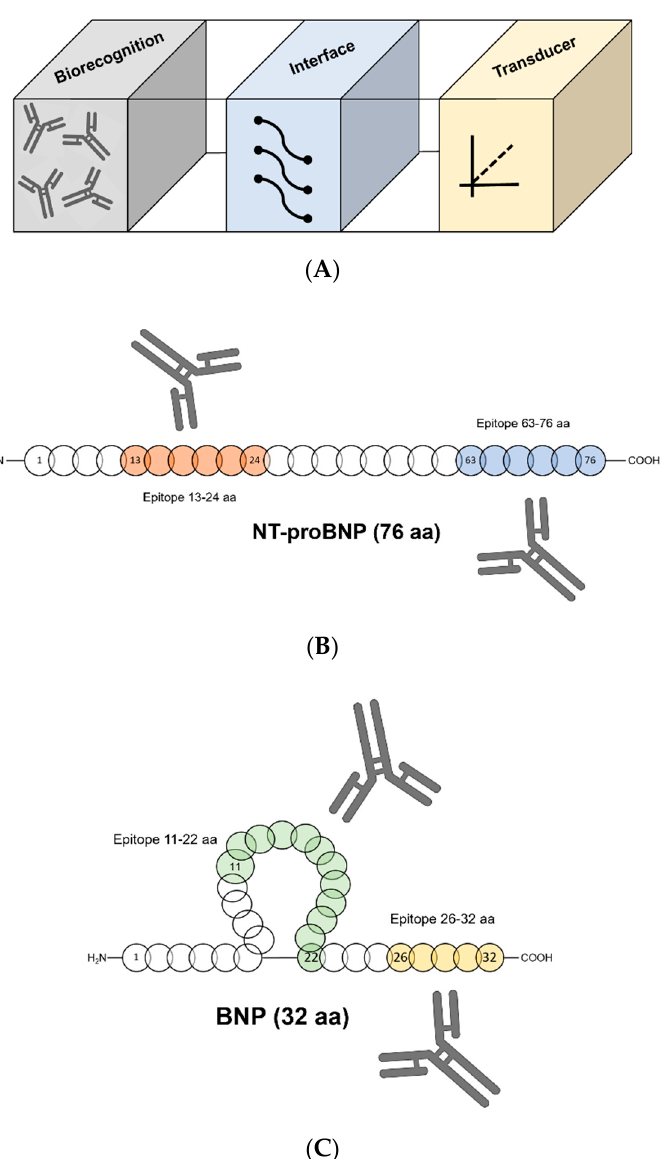
Figure 3. Detection of B-type natriuretic peptide. ( A ) Point-of-care biosensor platform; ( B ) N-terminal pro-B-type natriuretic peptide (NT-proBNP) epitopes (13–24 aa and 63–76 aa); ( C ) B-type natriuretic peptide (BNP) epitopes (11–22 aa and 26–32 aa).